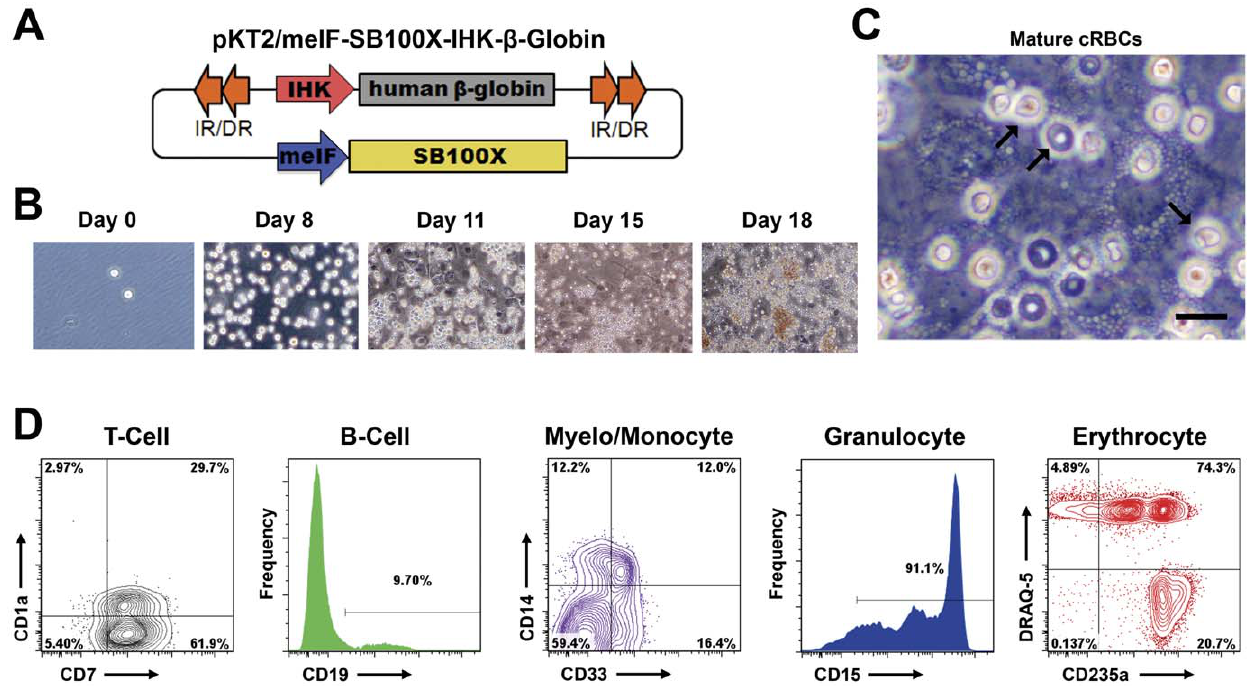
Figure 2. Nucleofected CD34 + cells retain their ability to differentiate invitro . ( A ) Schematic of cis IHK– b -globin SB construct (not to scale). ( B ) Photomicrographs (100 6 total magnification) show the progression through 18 days of erythroid differentiation. ( C ) Erythroid differentiation can proceed through enucleation of mature cultured red blood cells (cRBCs); black arrows from left-to-right: nucleated erythroid, enucleated biconcave, and recently enucleated cup-shaped cells in culture at day 18 (400 6 total magnification; black scale bar is 10 m m in length). ( D ) Each differentiation trial was stained for respective markers of differentiation at 1:100 dilutions in staining buffer. Gates were set using isotype controls or unstained controls as appropriate. A minimum of 5 6 10 3 singlet events was collected for each sample. Granulocyte cultures were stained with CD15-PE-Cy7 (left panel); erythrocyte cultures with CD235a-FITC and DRAQ-5 at 1:2000 (center left panel); B-cell cultures were stained for CD19-AlexaFluor700 (center panel); T-cell cultures with CD1a-FITC and CD7-AlexaFluor700 (center right panel); and myelocyte/monocyte cultures were stained with CD14-V450 and CD33-AlexaFluor700 (right panel).